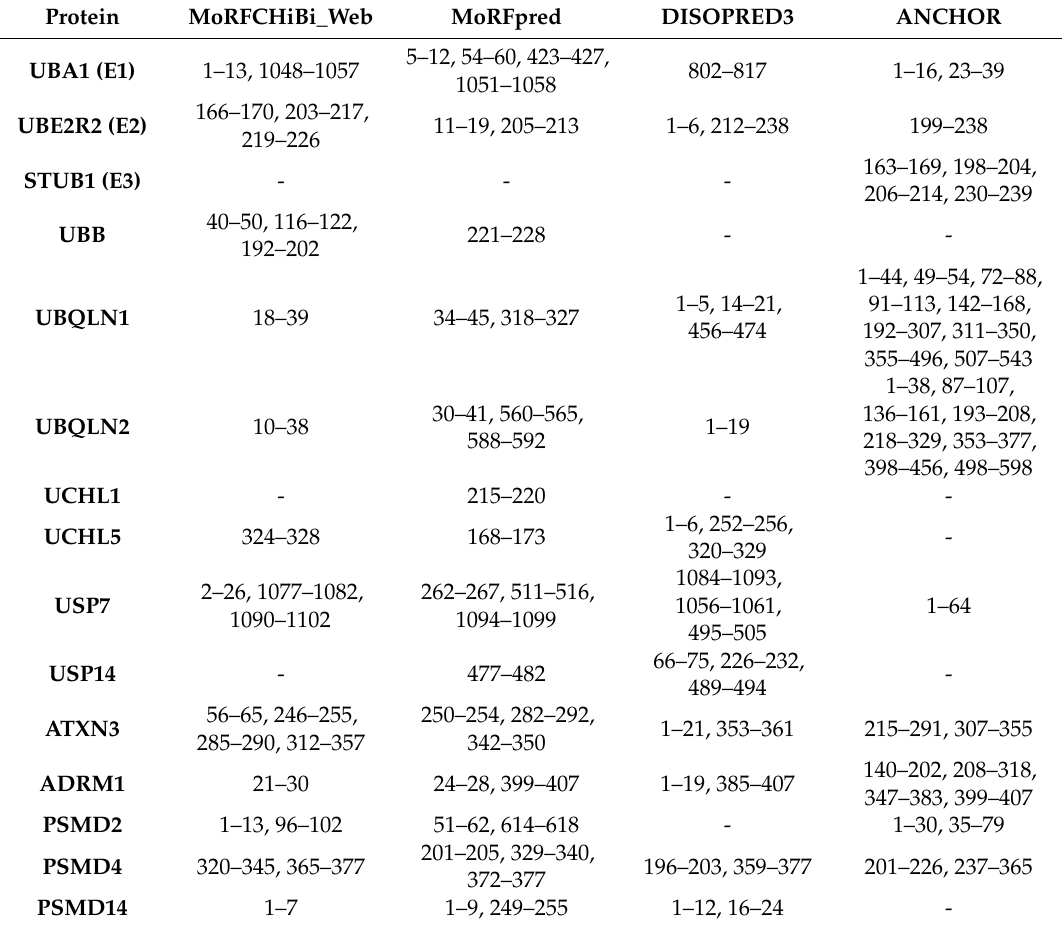
Table 3. Identification of MoRF regions for the proteins of